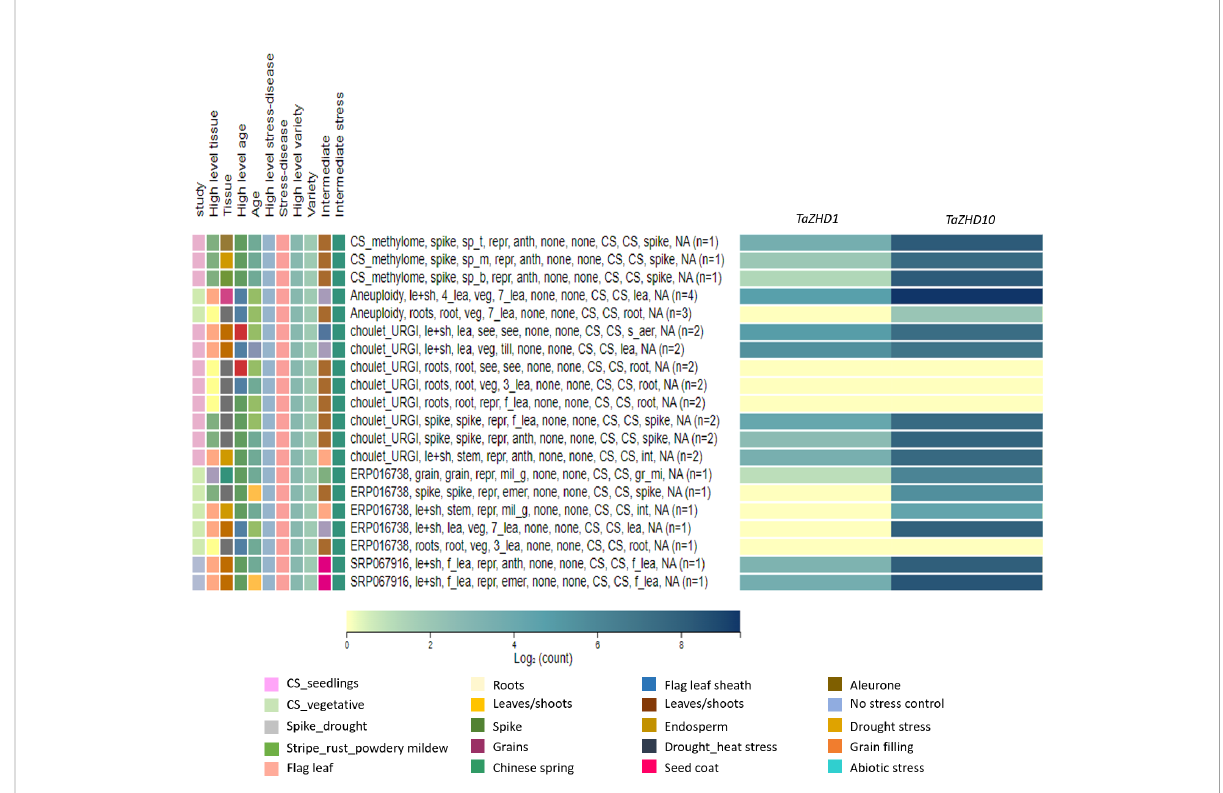
FIGURE 7 Transcriptome-wide expressions pro fi ling of candidate leaf rolling ZHD genes in wheat tissues at different developmental stages and under studied biotic and abiotic stress